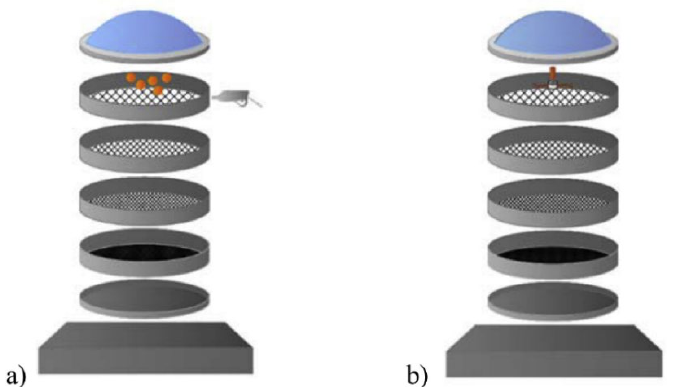
Figure 8. Schematic representation of a fiber cleaning procedure: ( a ) 1st step and ( b ) 2nd step [39].